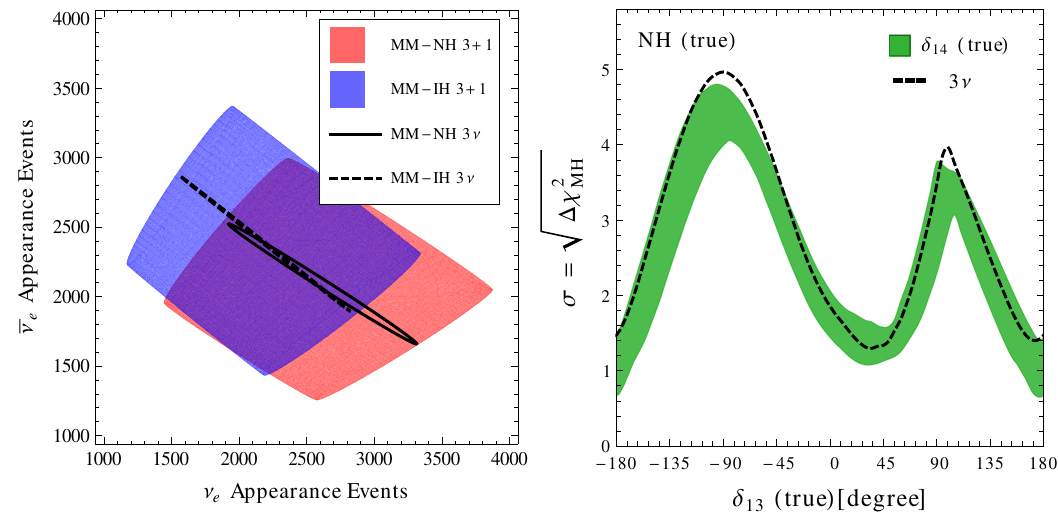
Figure 1 . Left panel: bievents plot for 3-(cid:13)avor (black ellipses) and 4-(cid:13)avor case (colored blobs). Right panel: discovery potential for identifying the correct hierarchy (NH) as a function of true (cid:14) 13 . We have (cid:12)xed true and test (cid:18) 14 = (cid:18) 24 = 9 0 . The black dashed line represents the 3-(cid:13)avor case, while the green band corresponds to the 3+1 scheme. Such a band is obtained by varying the true value of (cid:14) 14 in the range [ (cid:0) (cid:25); (cid:25) ] and marginalizing the test value of (cid:14) 14 in the same